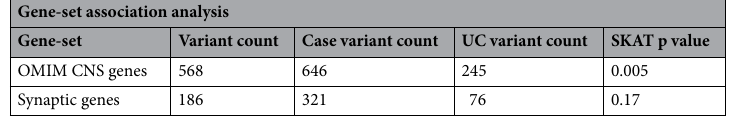
Table 3. Gene-set level cross-pedigree association